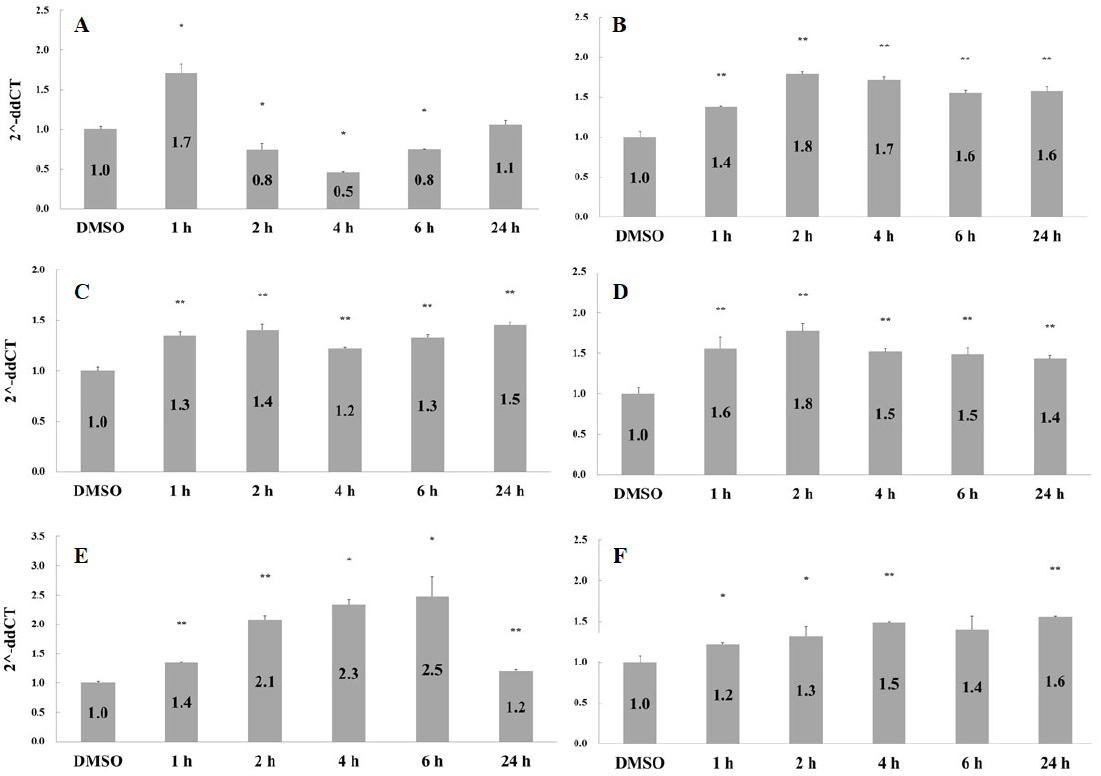
Figure 4. Effects of catechu extracts on gene expression. HMEC-1 cells were treated with 0.1 ng/mL of catechu extracts for 1, 2, 4, 6, and 24 h. The gene expression levels for ( A ) IL-8, ( B ) FGFR2, ( C ) FGFR3, ( D ) NF-kB, ( E ) STAT3, and ( F ) vimentin were examined by quantitative PCR. Data are presented as means ± SD in three independent experiments. The p -value was calculated versus the control. Using one-tailed test analysis, * indicates p < 0.05 and ** indicates p < 0.005 between different times after catechu treatment. The DMSO group was the solvent control.